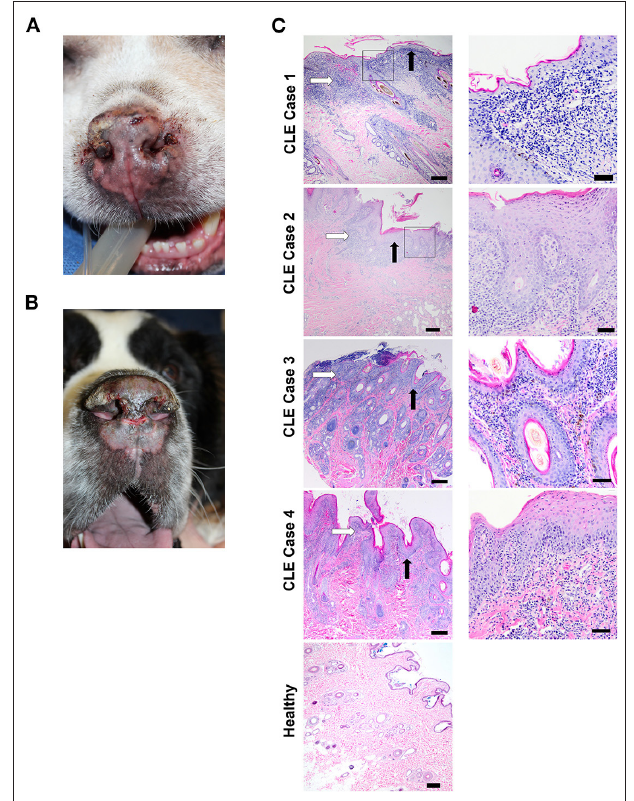
FIGURE 1 | Clinical features and histopathological findings of canine CLE cases. (A) Nasal planum exhibits scarring, dyspigmentation, loss of nasal architecture (loss of the normal cobblestone appearance), erosions/ulcerations, and hemorrhagic crusts. (B) Nasal planum exhibits atrophy and loss of nasal architecture, symmetrical erosions/ulcerations, and scarring on the dorsal muzzle. The dermatopathological hallmarks of canine CLE include a lymphocytic-rich interface dermatitis with basal keratinocyte damage that obscures the dermal-epidermal junction (DEJ). (C) CLE case 1, 2, 3, 4, and healthy skin margin H&E photomicrographs (left, 4x objective, right 20X objective). Basement membrane thickening, obscuring of the DEJ with basal keratinocyte damage (black arrows), and lymphocytic infiltration (white arrows) are observed in all cases. [Scale bars 4x objective images = 200 µ M, 20x objective images = 50 µ